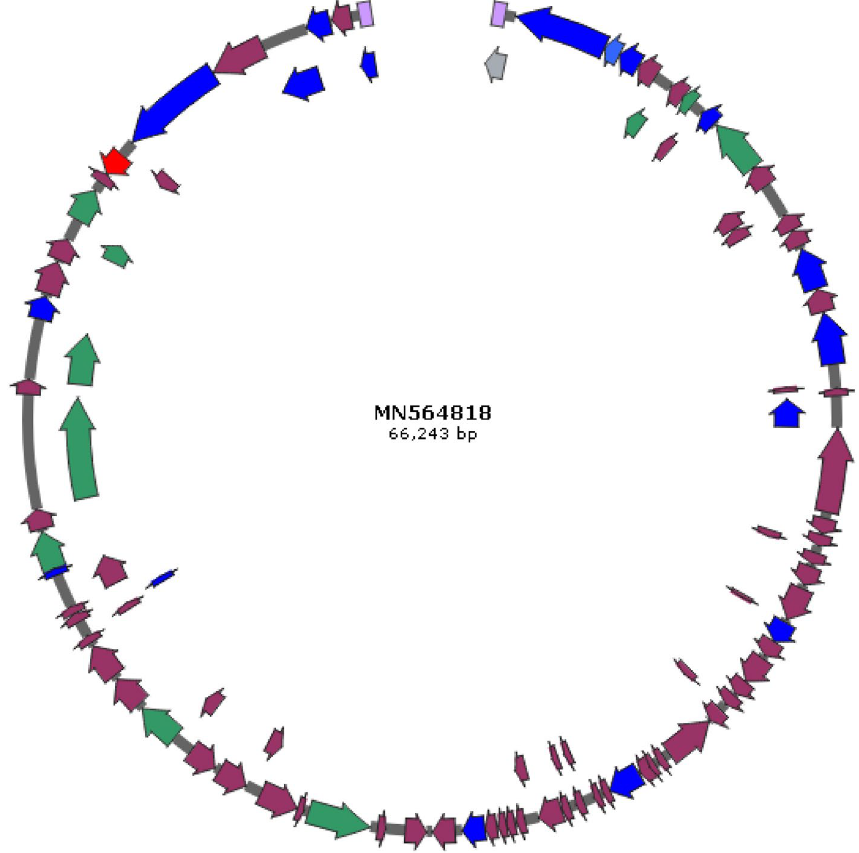
Figure 3. Complete genome map of 66,243 bp DRL-P1 dsDNA, visualized by SnapGene tool trial version (https:// www. snapg ene. com/). ORFs annotated by GeneMarkS and PHASTER servers are represented as